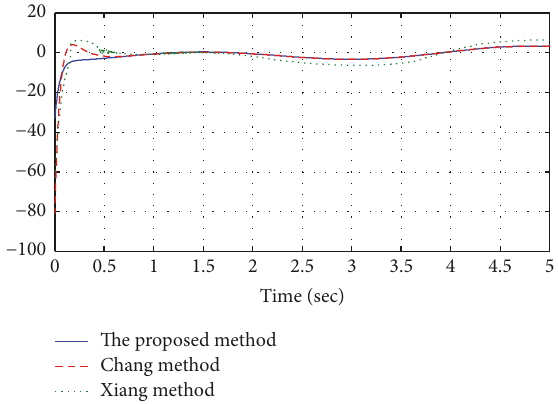
Figure 6: System input of the three